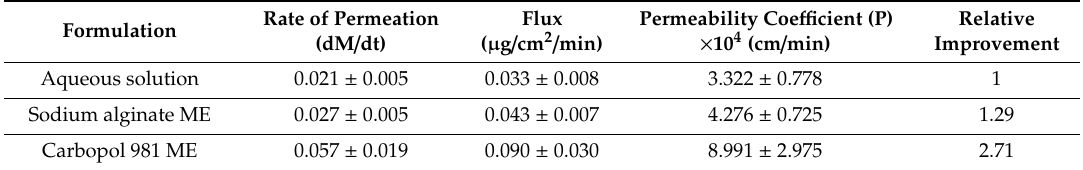
Figure 4. ( A ) In vitro transcorneal permeability profiles of ribavirin from Carbopol 981 and sodium alginate MEs and an aqueous solution as a control formulation (mean ± SEM, n = 4). ( B ) Histogram of the percentage cell viability of Carbopol 981 and sodium alginate MEs using HCLE cell line at different incubation times (mean ± SEM, n = 8). Table 3. In vitro transcorneal permeability parameters of ribavirin from Carbopol 981, sodium alginate MEs and an aqueous solution as a